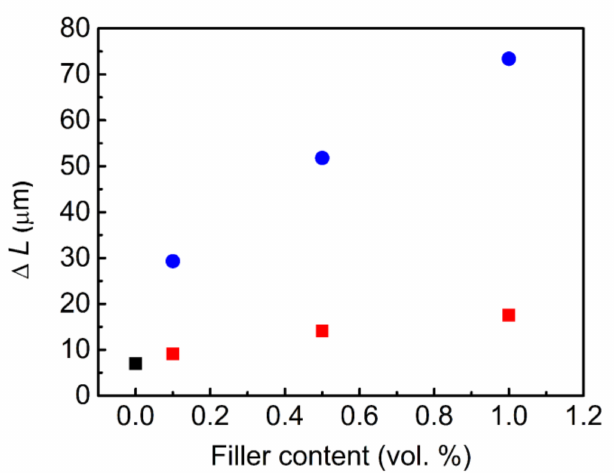
Figure 9. Dependence of the filler content on the change in length, for pure PDMS matrix (black squares), PDMS composites containing unmodified GO (red squares), and GO-PHEMATMS (blue circles). Error bars are within the size of the